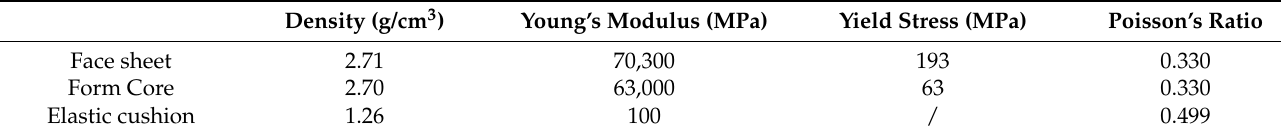
Table 2. Material parameters of AFSP and elastic cushion.